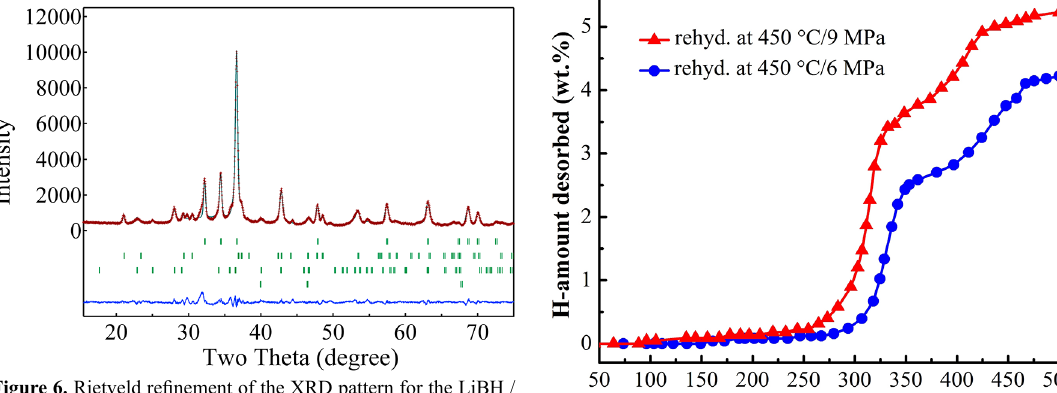
Figure 6. Rietveld refinement of the XRD pattern for the LiBH Mg YNi-H composite dehydrogenated at 450 ºC. The vertical bars 10 (from above) indicate the positions of Bragg diffraction for Mg, MgNi B , YB and LiH, respectively. (The reliability factors for 2.5 2 4 refinement are R = 8.96%, R = 6.42% and S = 2.38) wp p